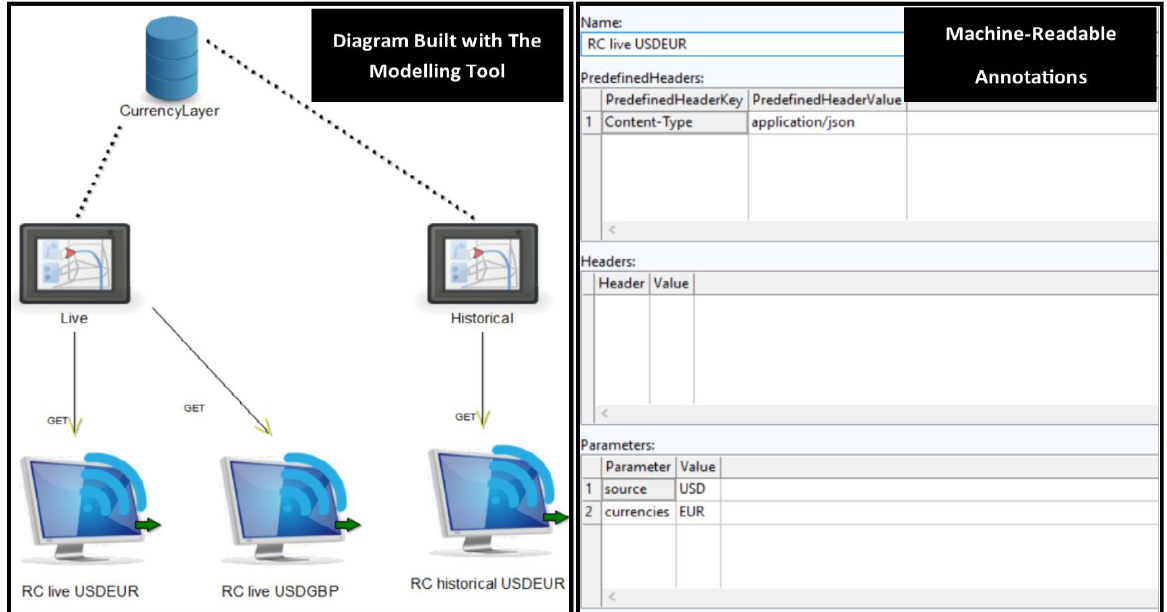
Figure 7. API Diagram built with the presented modeling tool (left) and machine-readable annotations of an HTTP Request Configuration